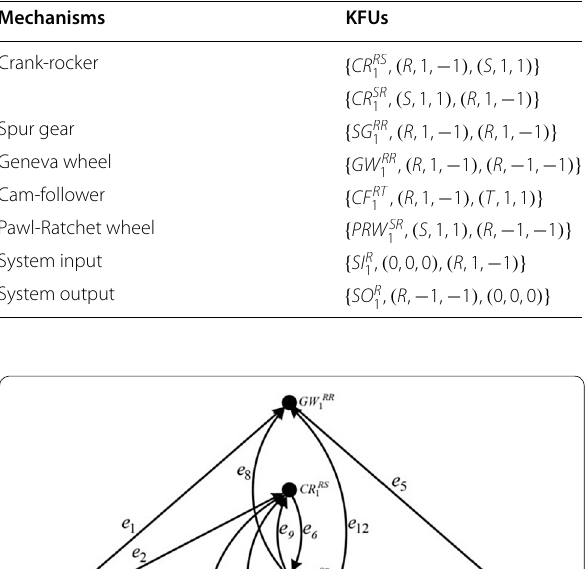
Table 2 Eight KFUs from seven mechanisms Mechanisms